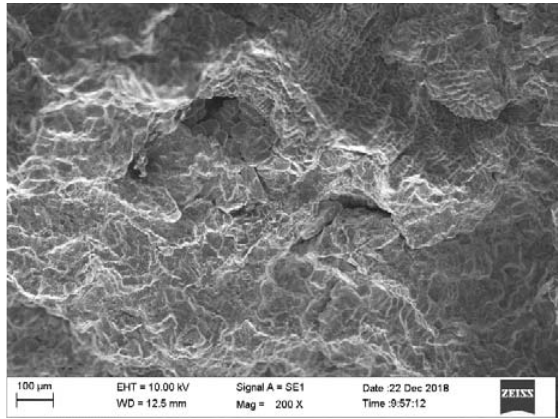
Figure 3: Fracture images of un-heat treated composites.